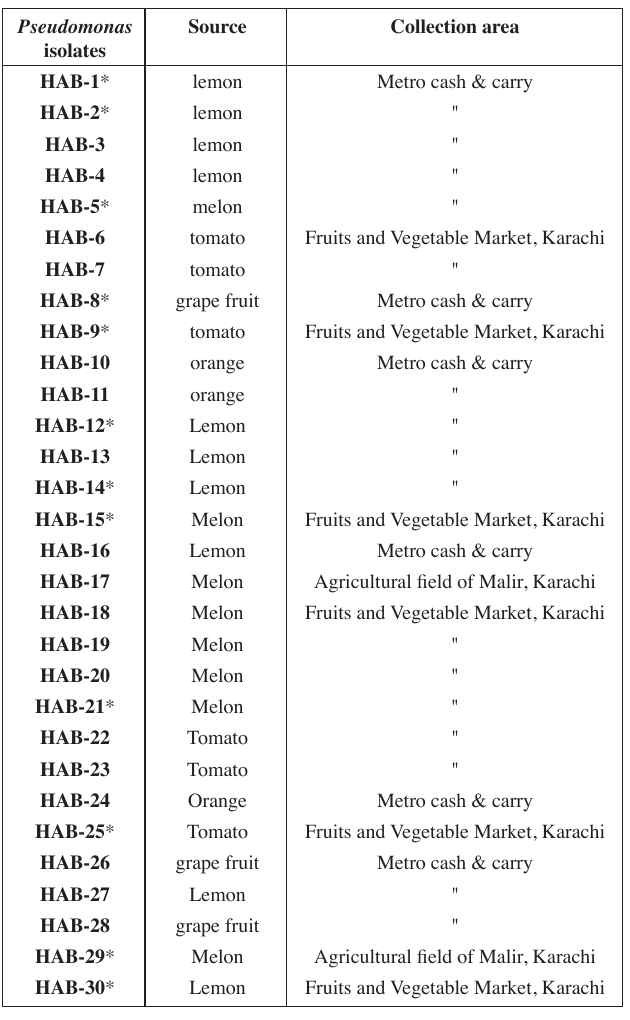
Tab. 2: List of different isolates of epiphytic fluorescent Pseudomonas iso- lated from healthy fruits and vegetables. Pseudomonas